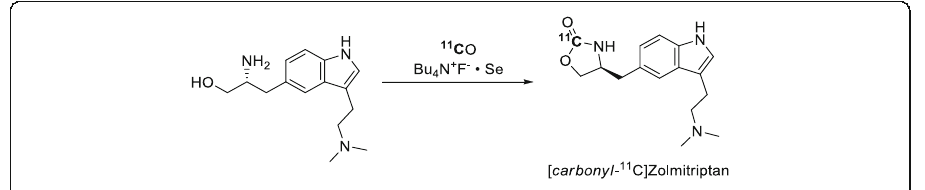
Fig. 33 Radiosynthesis of [ 11 C]zolmitriptan through Se-mediated 11